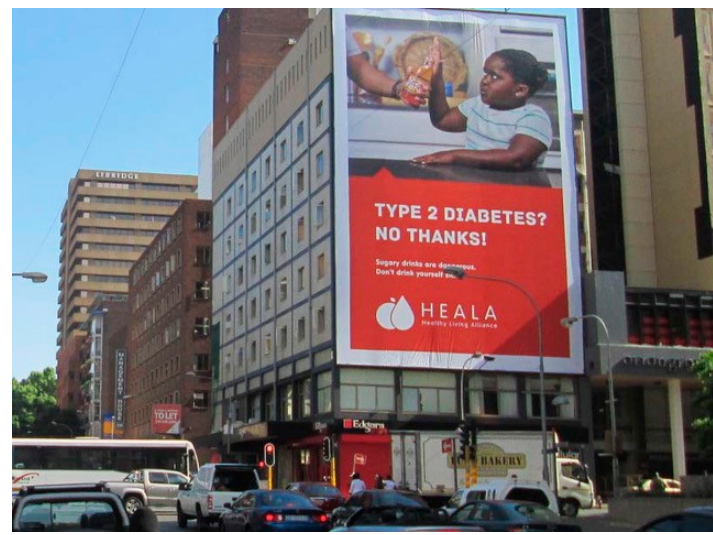
Figure 2. Photograph of outdoor media (billboard) from the campaign, “Type 2 diabetes? No thanks!”